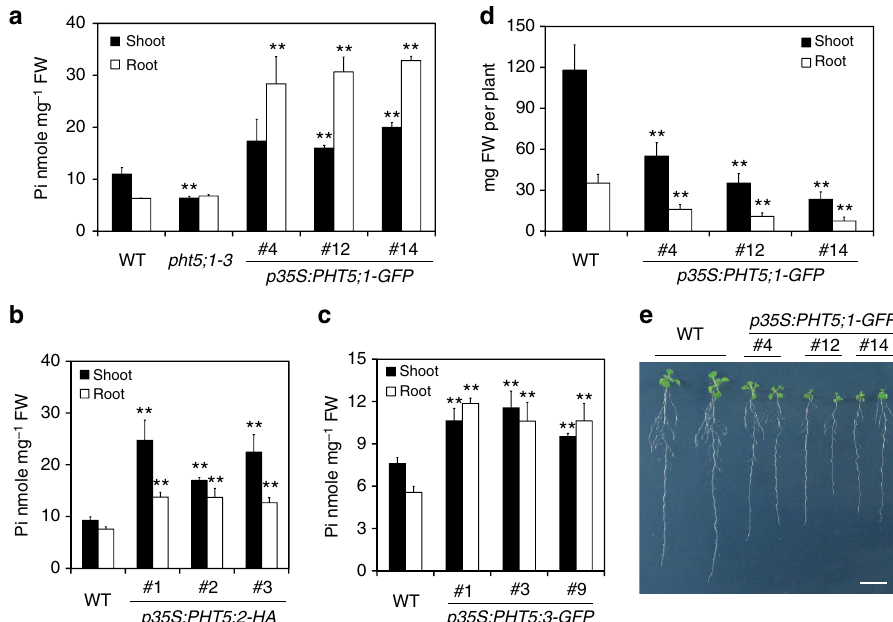
Figure 3 | Overexpression of PHT5 leads to Pi overaccumulation and retarded growth. The Pi level of the shoots and roots of PHT5- overexpressing lines grown under Pi-sufficient conditions. p35S:PHT5;1-GFP in a , p35S:PHT5;2-HA in b and p35S:PHT5;3-GFP in c . The fresh weight of 21-day-old seedlings ( d ) and the growth phenotypes of 11-day-old seedlings ( e ) of PHT5;1-GFP- overexpressing lines. Scale bar, 1cm. Three independent transgenic lines are shown for each construct. Error bar, s.d. ( n ¼ 3). Asterisks indicate a significant difference compared with WT, * P o 0.05 and ** P o 0.01, Student’s t -test. Results were reproducible in at least three independent